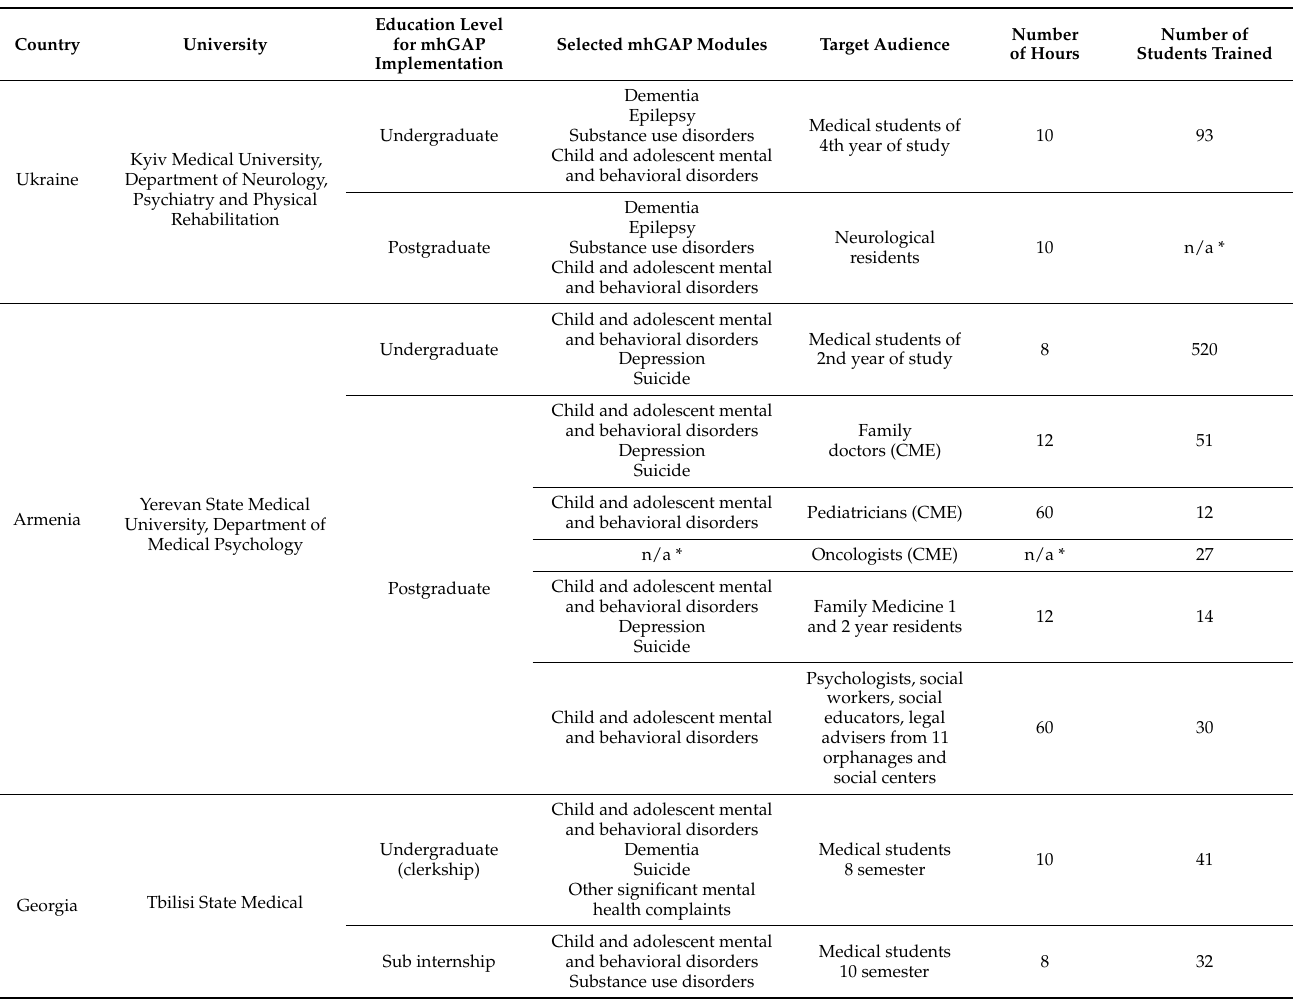
Table 3. Implementation of the Mental Health Gap Action Programme Intervention Guide (mhGAP-IG) into education settings in Ukraine, Armenia, Georgia, and Kyrgyz